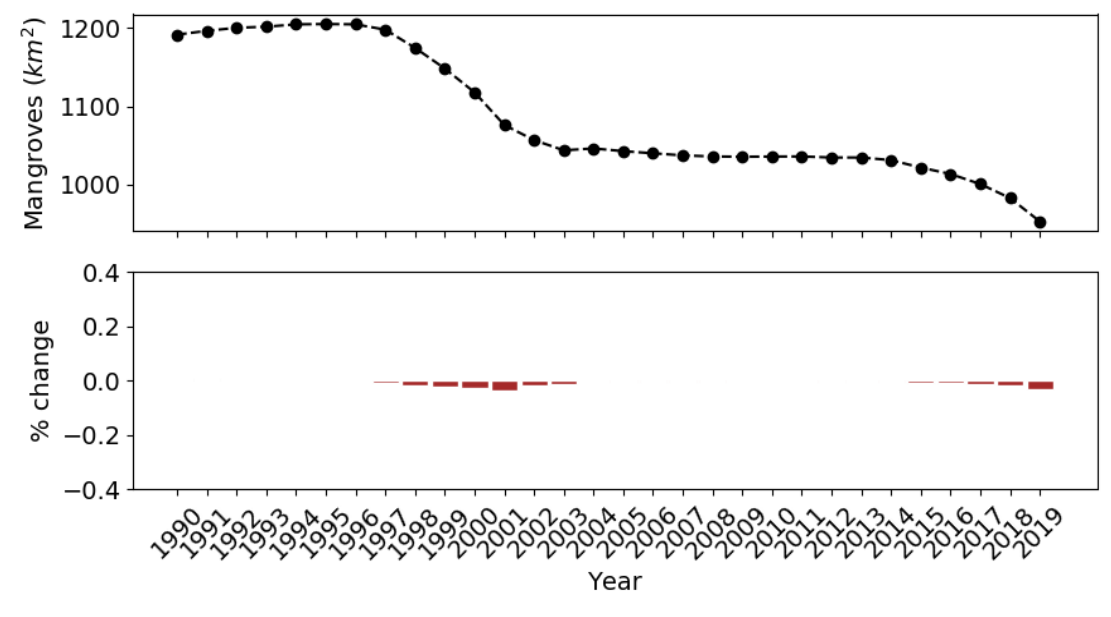
Figure 9. Mangrove extent over time for the site in North Kalimantan, Borneo island.